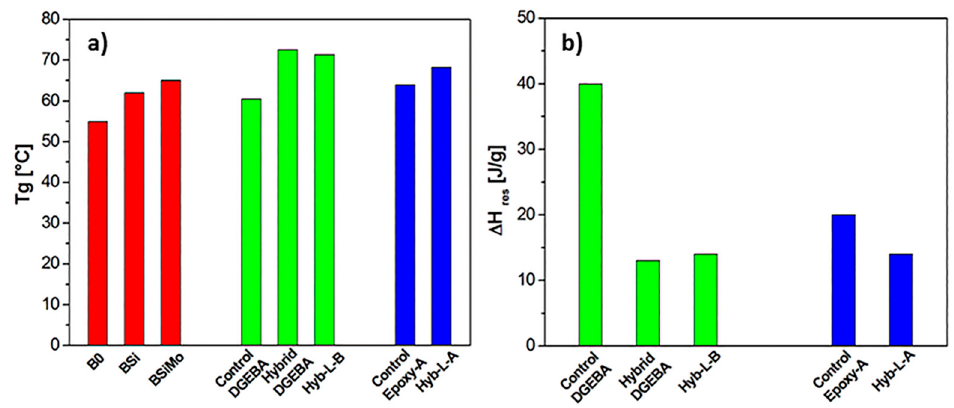
Figure 3. Final ( a ) glass transition temperatures ( T g ) and ( b ) residual heat of reaction, ( ∆ H res ), measured on cold-cured systems: B0, BSi, and BSiMo; Control DGEBA, Hybrid DGEBA, Hyb-L-B; Control Epoxy-A, Hyb-L-A systems.